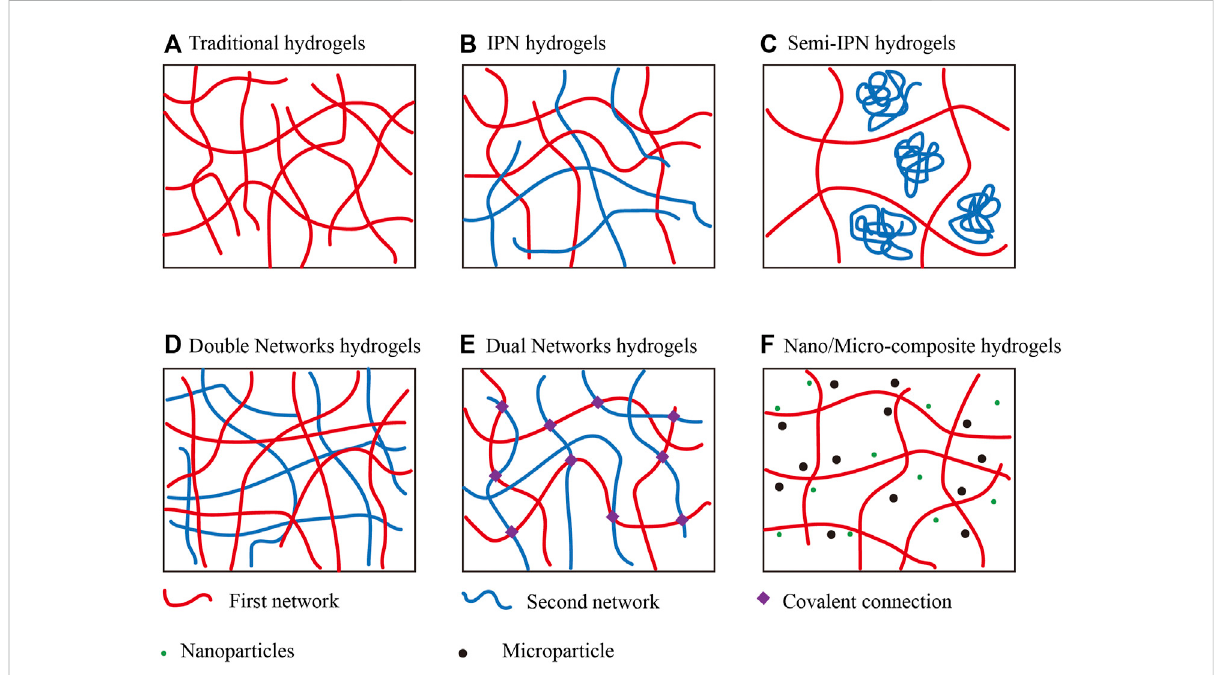
FIGURE 3 The schematic diagram depicts injectable hydrogels with different structures for cartilage regeneration engineering (A) . Traditional single polymer networks. (B – F) . Different multiscale structure of injectable hydrogels. Reproduced with permission of Vega et al.